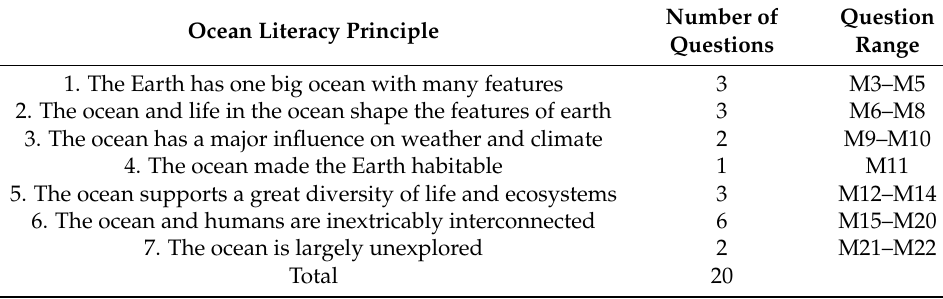
Table 2. Group of questions associated with the seven principles of ocean